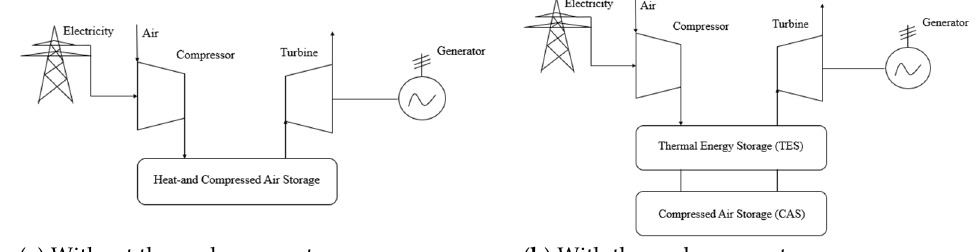
Figure 20. Systems with adiabatic CAES.